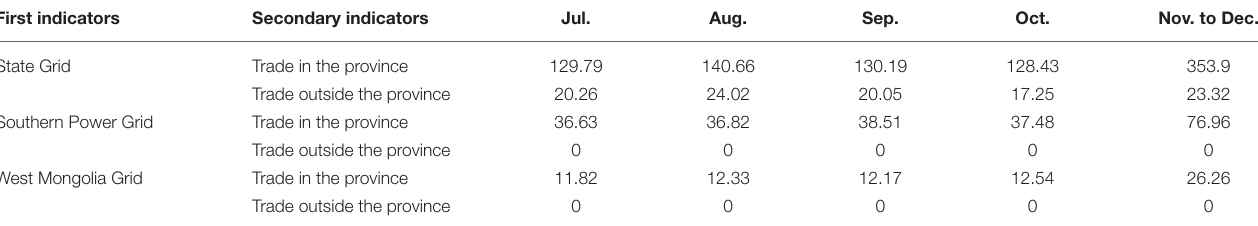
TABLE 2 | Inter-regional and inter-provincial transaction quantity from July to December 2019 (Unit: TW · h). First